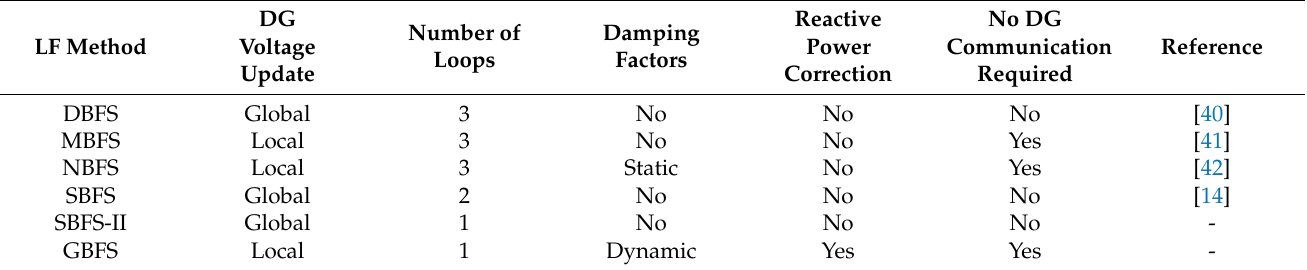
Table 1. Comparison between BFS-based load-flow methods for islanded